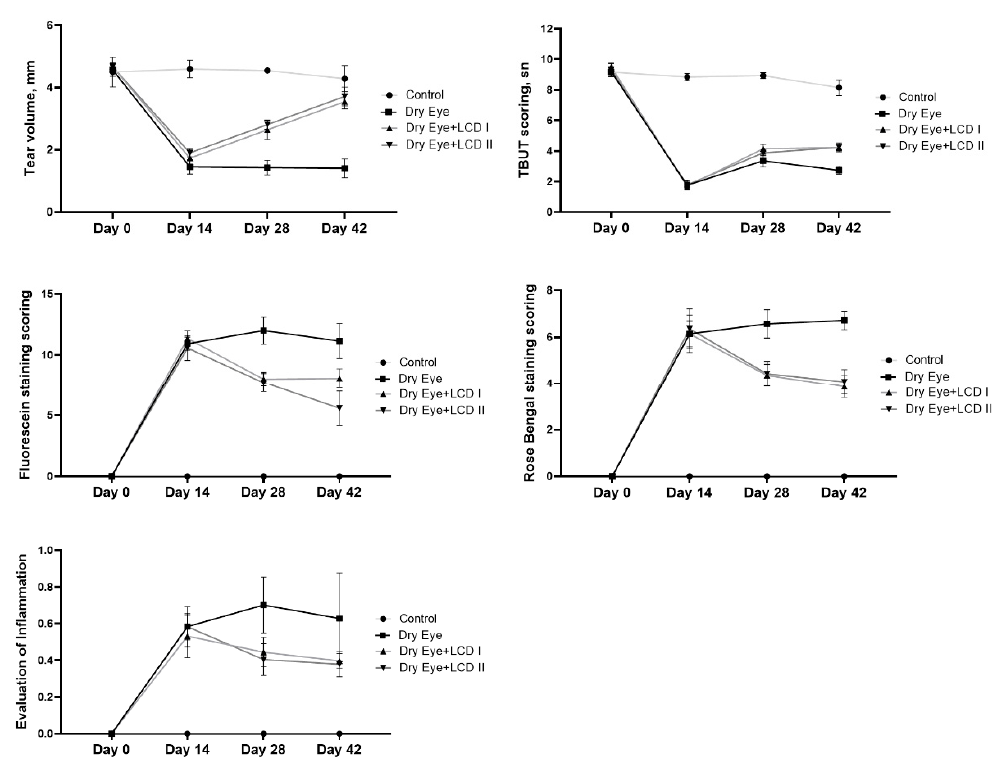
Figure 3. Effect of the combination of lutein/zeaxanthin, curcumin, and vitamin D (LCD) on tear volume, tear breakup time (TBUT) scoring, Fluorescein staining scoring, Rose Bengal staining scoring and evaluation of inflammation in benzalkonium chloride (BAC)-induced dry eye syndrome in rats on days 0, 14, 28 and 42 ( n = 7 per group). Control: No treatment; Dry Eye: BAC-induced dry eye syndrome; LCD I; Dry Eye + LCD I: BAC-induced dry eye syndrome plus LCD I (100 mg/kg body weight); Dry Eye + LCD II: BAC-induced dry eye syndrome plus LCD II (200 mg/kg body weight).